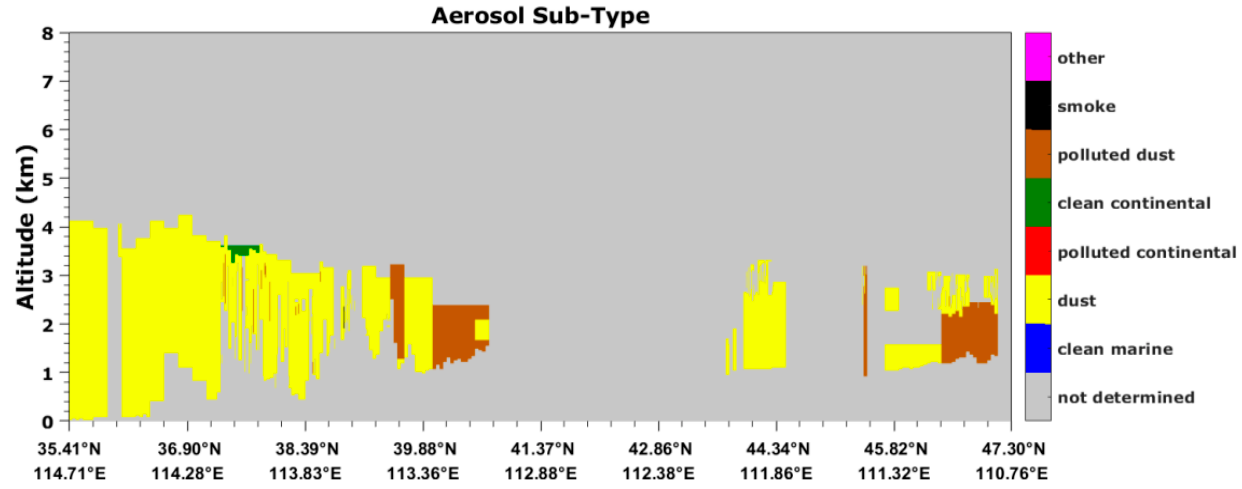
Figure 9. Distribution of aerosol types on 4 March.